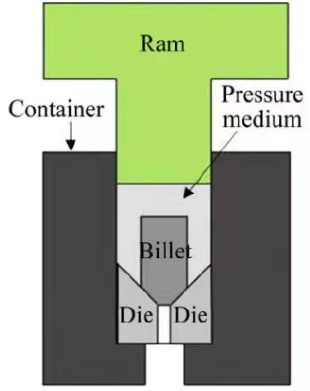
Figure 16. Schematic diagrams of hydrostatic extrusion reprinted with permission from Ref. [54]. Copyright 2022 ELSEVIER.